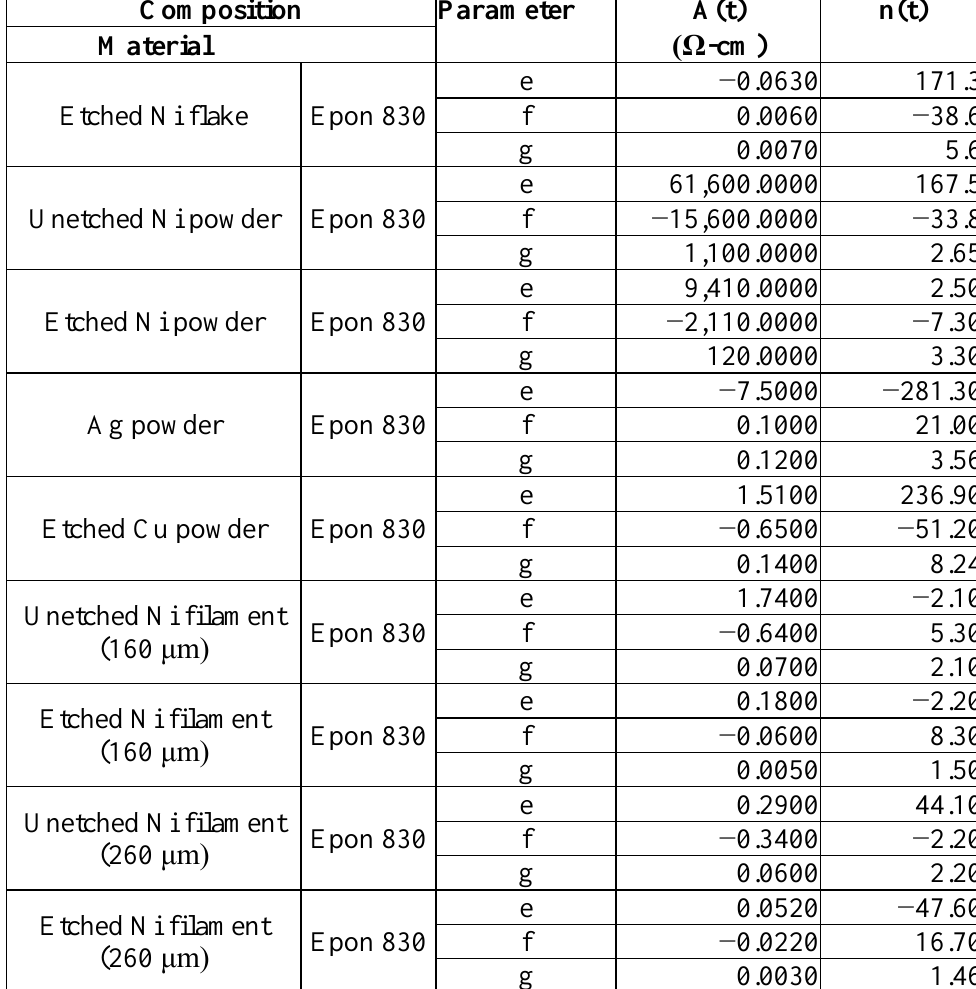
Table 8. The parameters e, f and g of Equation 18 for A(t) and n(t) with various filled Epon 830 adhesive